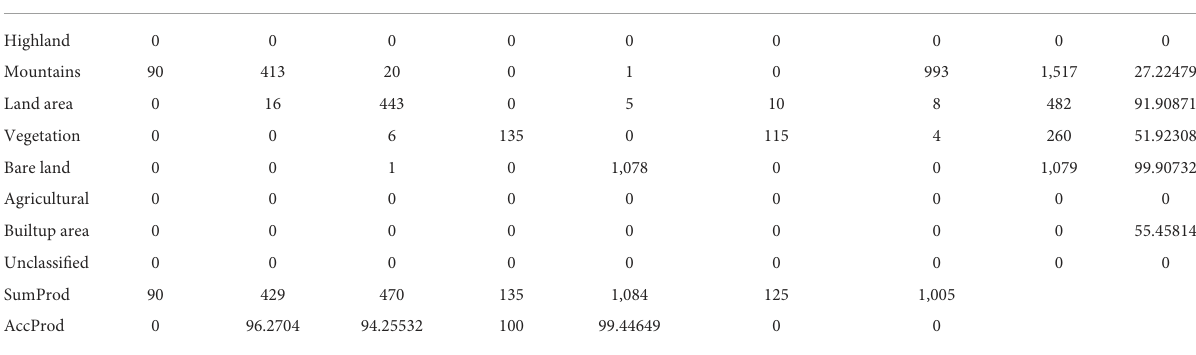
TABLE 8 Confusion matrix for ANN method of Landsat-8 satellite 2016.